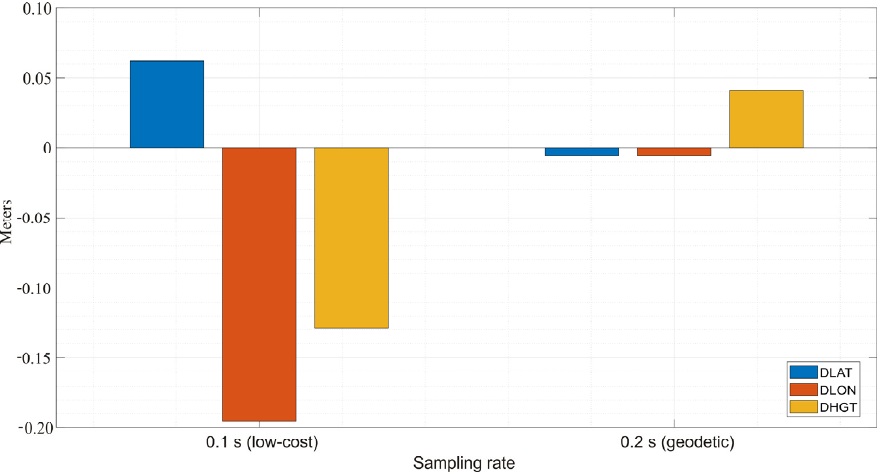
Figure 12. Difference between estimated and precise positions of low-cost and geodetic receivers at 0.1 and 0.2 s respectively, by processing with PPP-kinematic mode.